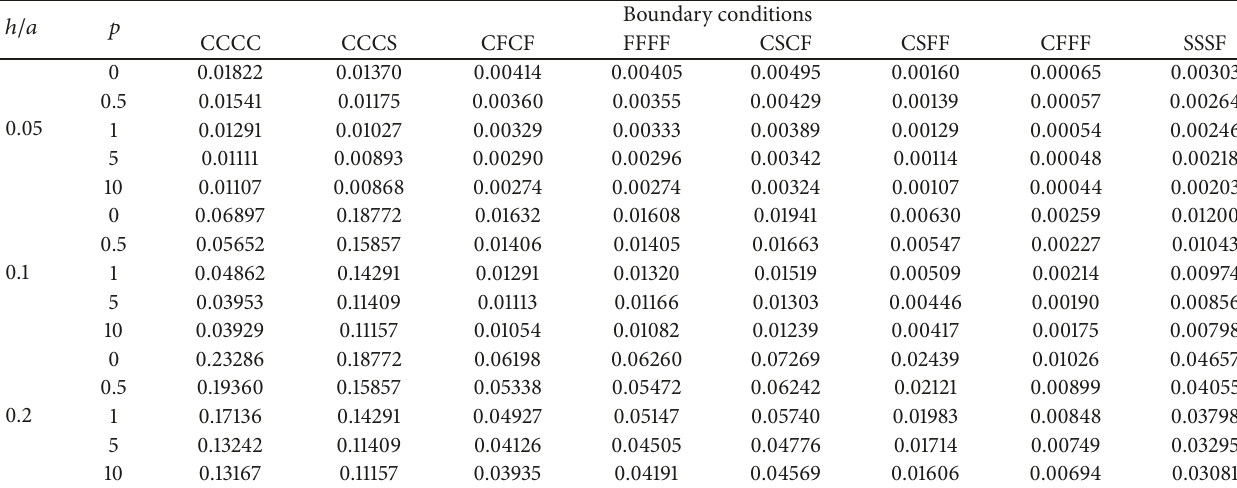
Table 11: Fundamental frequency parameter Ω = 𝜔ℎ(𝜌 𝑐 /𝐸 𝑐 ) 1/2 for Al/Al 2 O 3 plates with different boundary conditions.